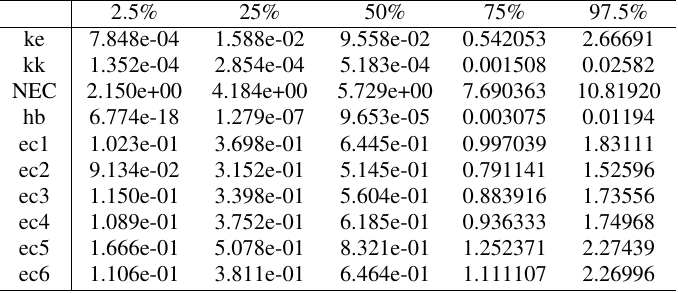
Q UANTILES FOR EACH VARIABLE